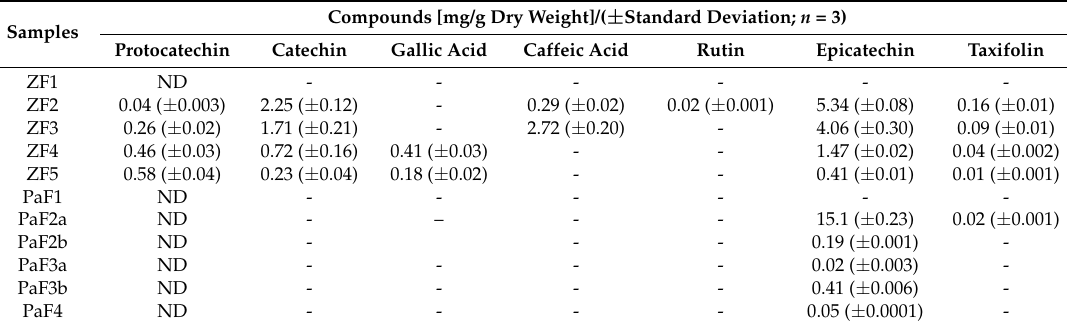
Legend: ND-not detected; Standard deviations are for intraday variation.